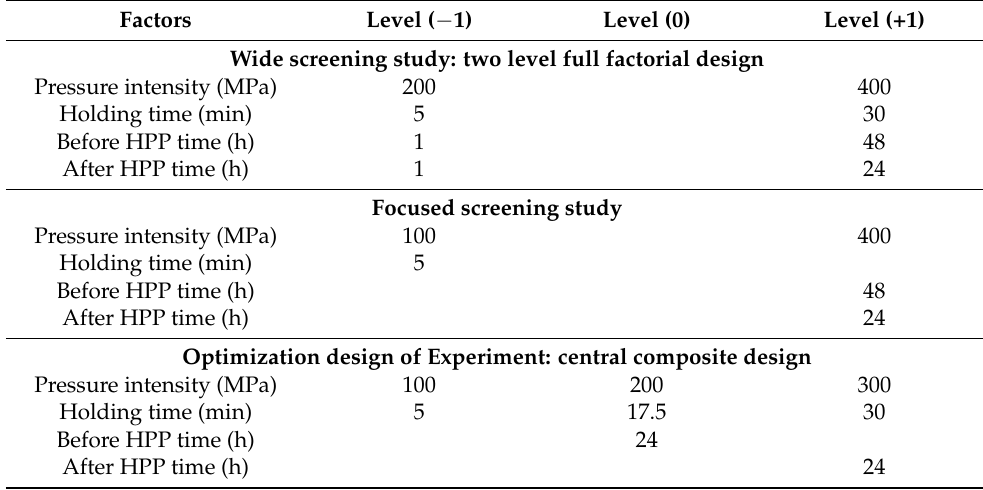
Table 1. Factors and levels for the initial wide screening and focused screening studies and optimiza- tion design of experiment (HPP stands for high-pressure processing).